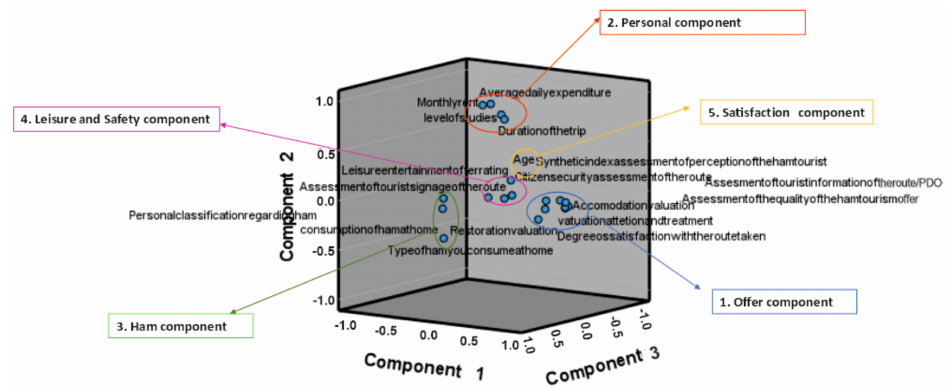
Figure 9. Component chart in rotated space.